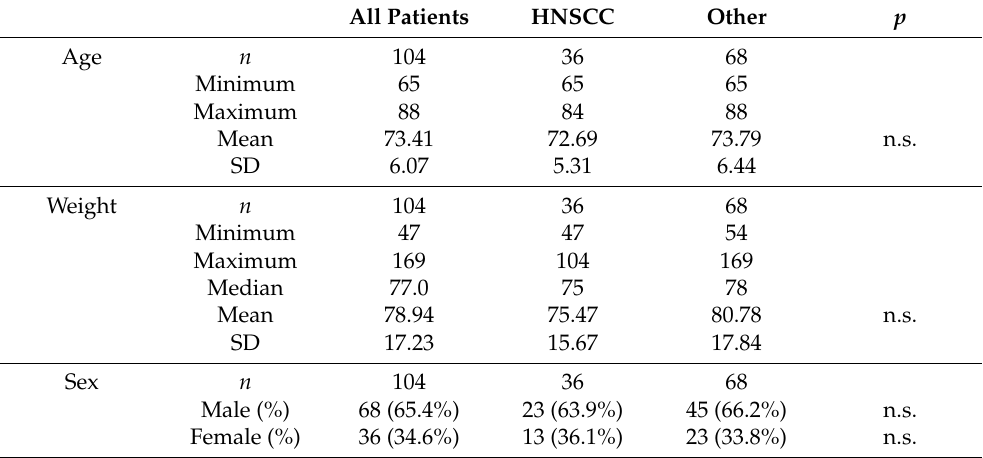
Table 1. Demographic parameters of the study cohort, HNSCC and other ENT diagnoses.